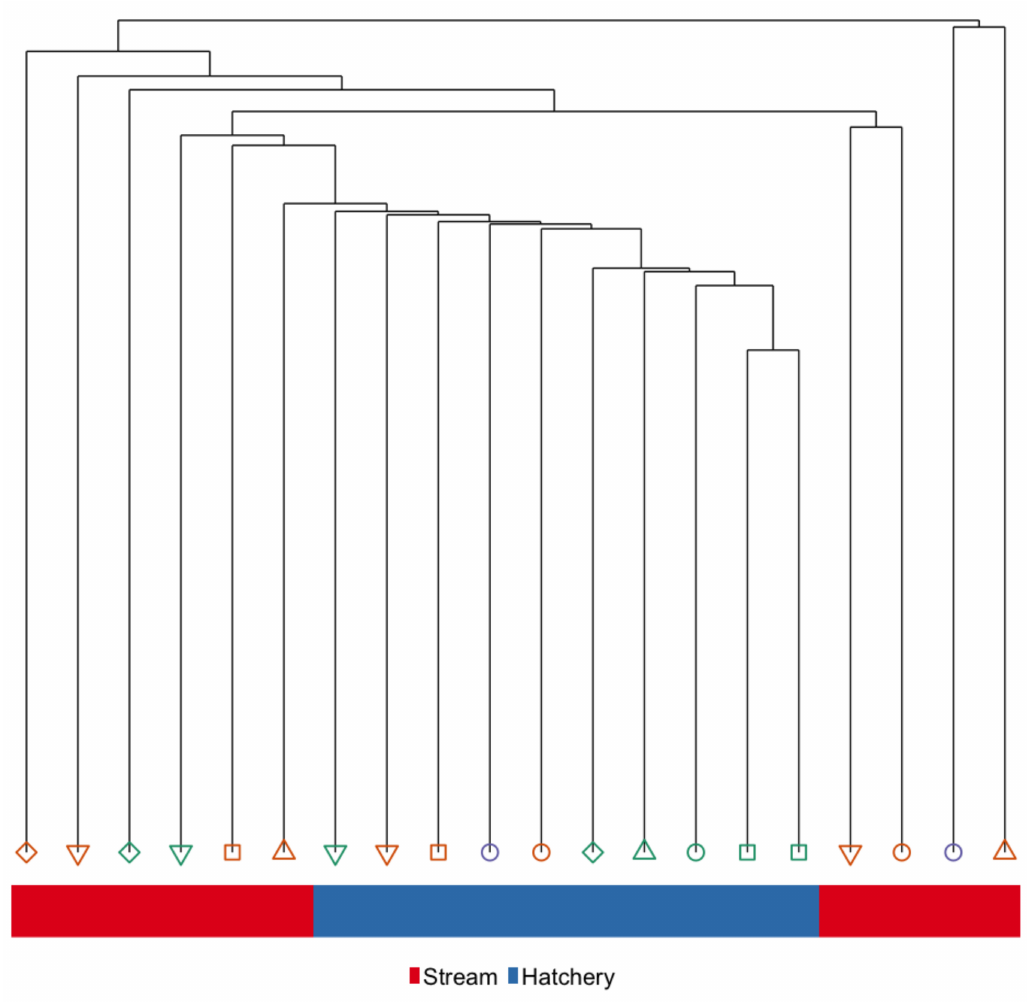
Figure 3. Hierarchical clustering of global hepatic DNA methylation patterns in the Immediate sample set. Color of the bar represents rearing-treatment and color / shape represents